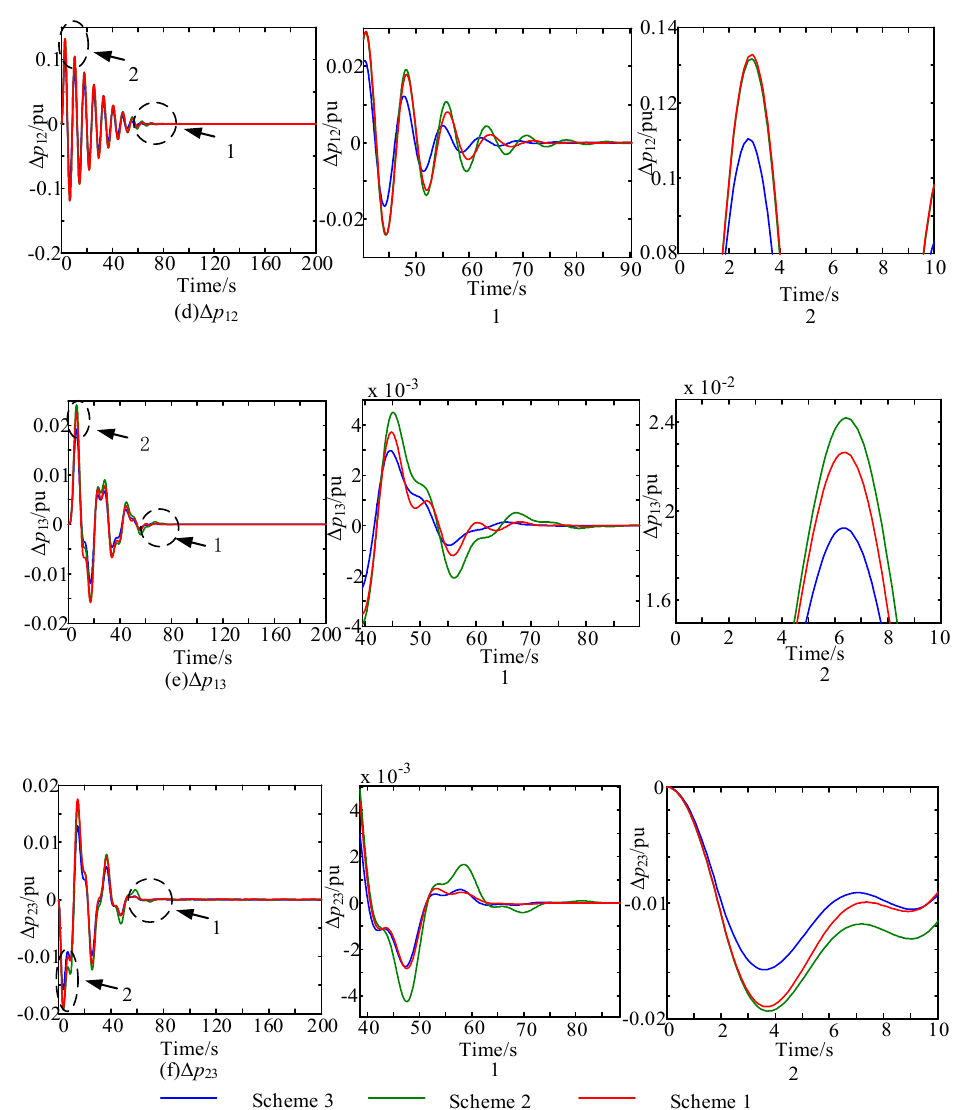
Figure 4. Results contrast curve under constrained: ( a ) frequency deviation of the first CA; ( b ) frequency deviation of the second CA; ( c ) frequency deviation of the third CA; ( d ) tie-line power deviation between the first and second CAs; ( e ) tie-line power deviation between the first and third CAs; ( f ) tie-line power deviation between the second and third CAs. Table 3. The parametric description of simulation results.